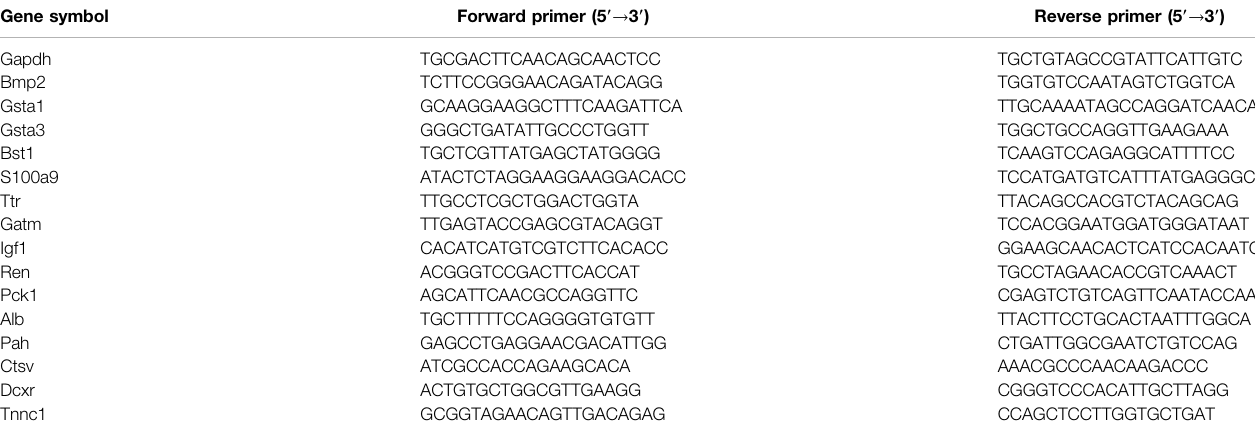
TABLE 1 | Primers used in the real-time PCR analysis. Gene